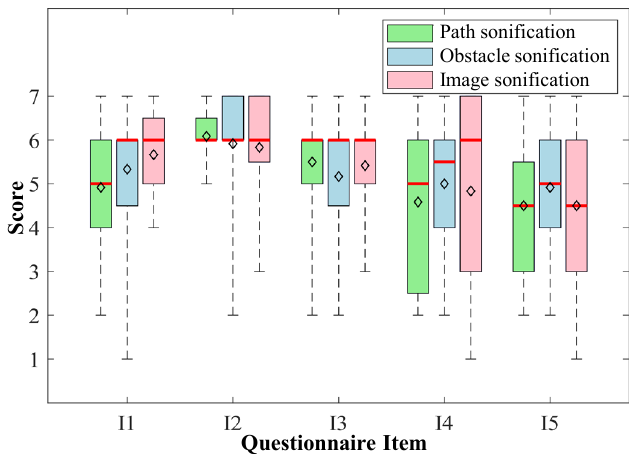
Figure 7. Box chart of the questionnaire results. I1 to I5 indicate five items of questionnaire for evaluating scene representation, navigation, complexity, comfort and overall satisfaction, and the score is based on the 7-point Likert scales, where 1 means strongly disagree and 7 means strongly agree. The median and mean values of each item are shown in red lines and diamond markers